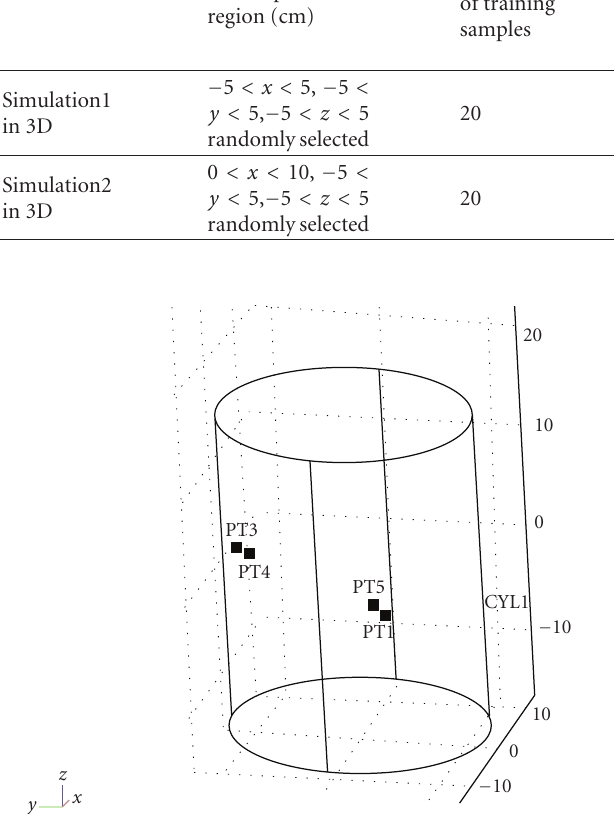
Figure 4: Two estimations of source position in the second simula- tion we